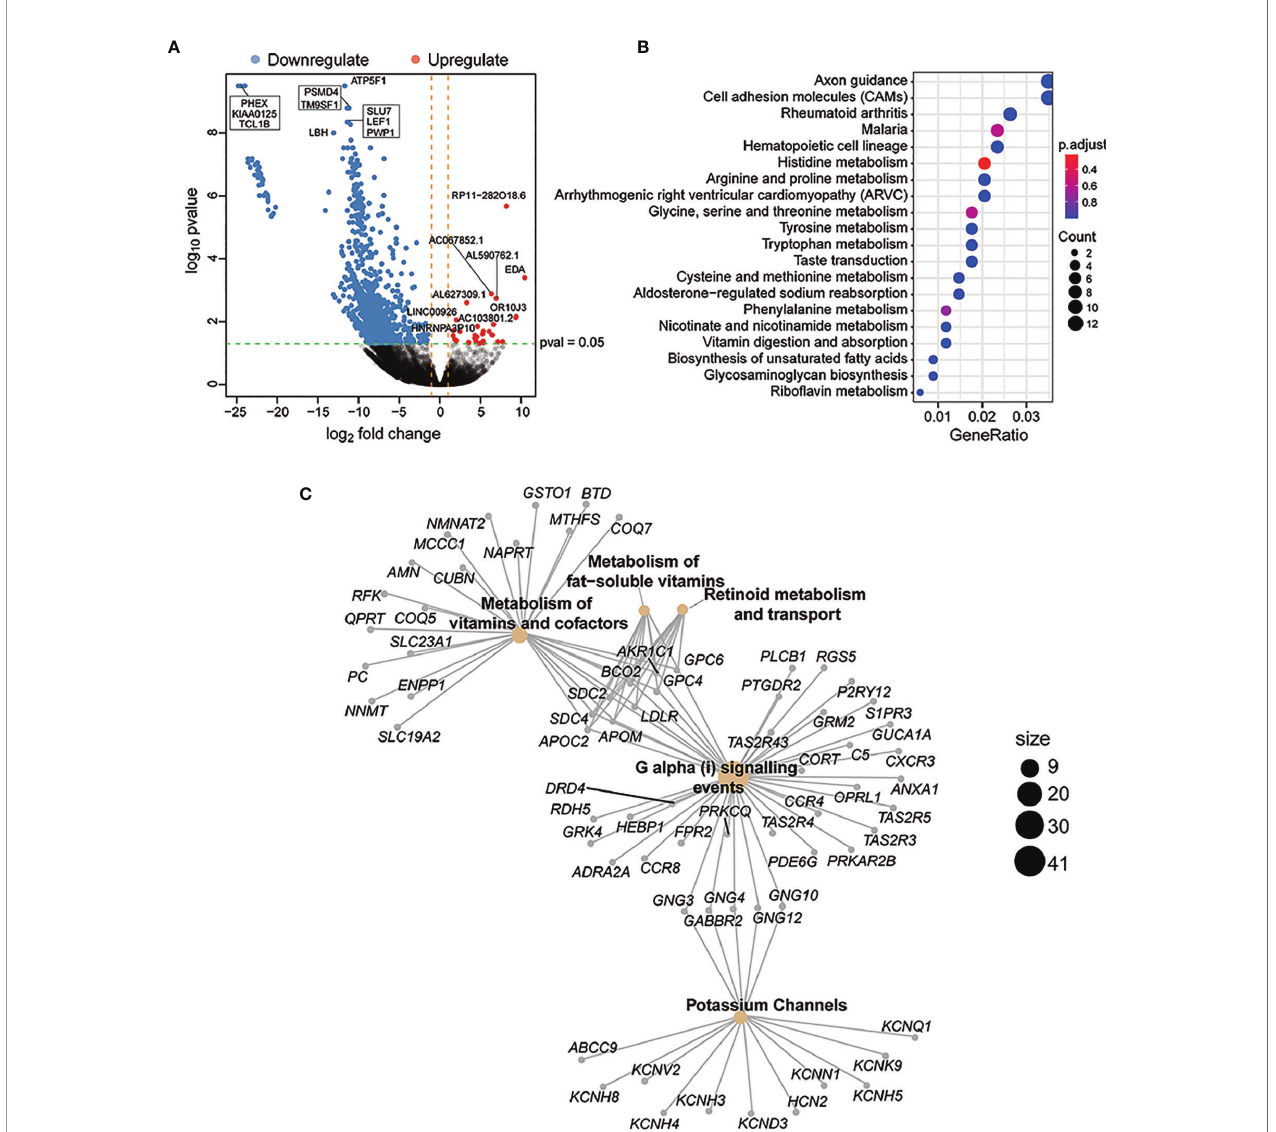
FIGURE 5 | Differential risk-related enrichment of gene sets in CDP and non-CDP groups. A total of 131 genes were identi fi ed as signi fi cantly differentially expressed with a p value ≤ 0.05 and |log2F C| ≥ 1 (A) . GO enrichment analysis of these genes suggested that some major categories of biological processes, especially for intracellular metabolism mechanism, had been signi fi cantly altered for the CDP group compared to the non-CDP group. The y-axis represented different gene function entries, and the x-axis represented the proportion of differentially expressed genes in the corresponding entries to all genes in the entry. The “ count ” of the circle represented the number of differentially expressed genes enriched in the corresponding entry (B) . Reactome network revealed differential gene expression between CDP and non-CDP groups. The yellow dots indicated signi fi cantly enriched Reactome entries, the “ size ” of the dots indicated the number of genes, and the gray dots indicated genes (C)